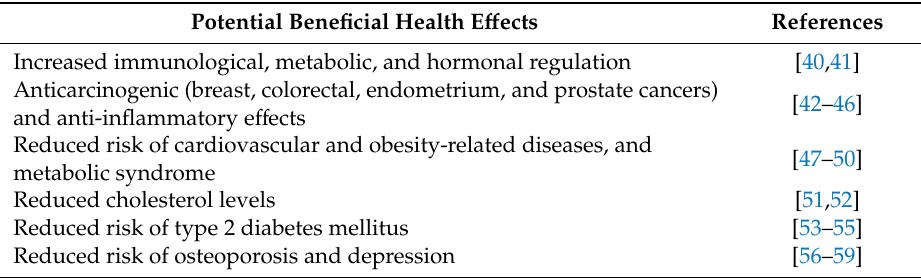
Table 1. Summary of the potential beneficial e ff ects of legume consumption on human